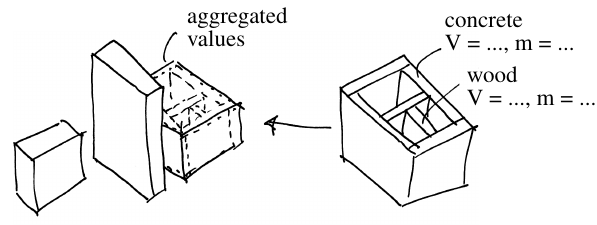
Figure 5. Use case 2: Material life-cycle assessment on the building model (right) followed by large scale material stock analysis on the city model